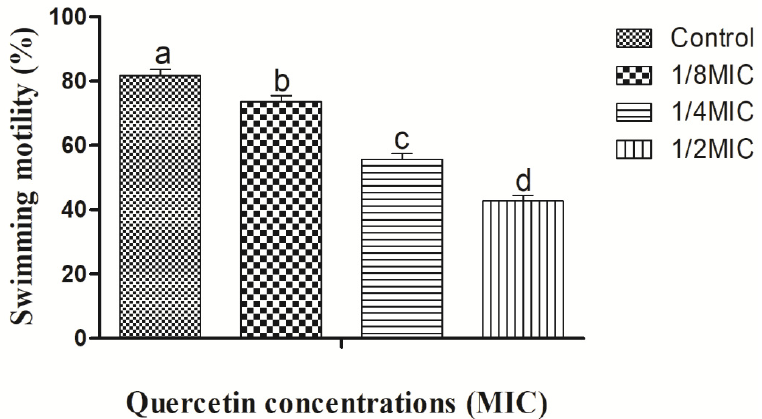
Figure 2. Swimming motility assay for Vibrio parahaemolyticus with sub-MICs of quercetin (µg/mL). Data are represented as mean ± SEM of three independent replicates. a–d Values with different letters differ significantly different by Duncan’s multiple-range test ( p < 0.05).